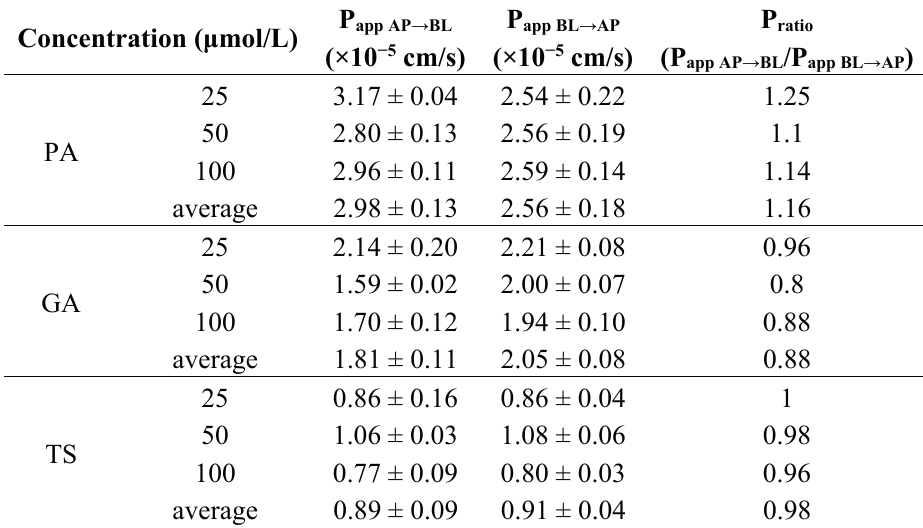
Table 2. P app values of PA, GA and TS obtained with Caco-2 model.